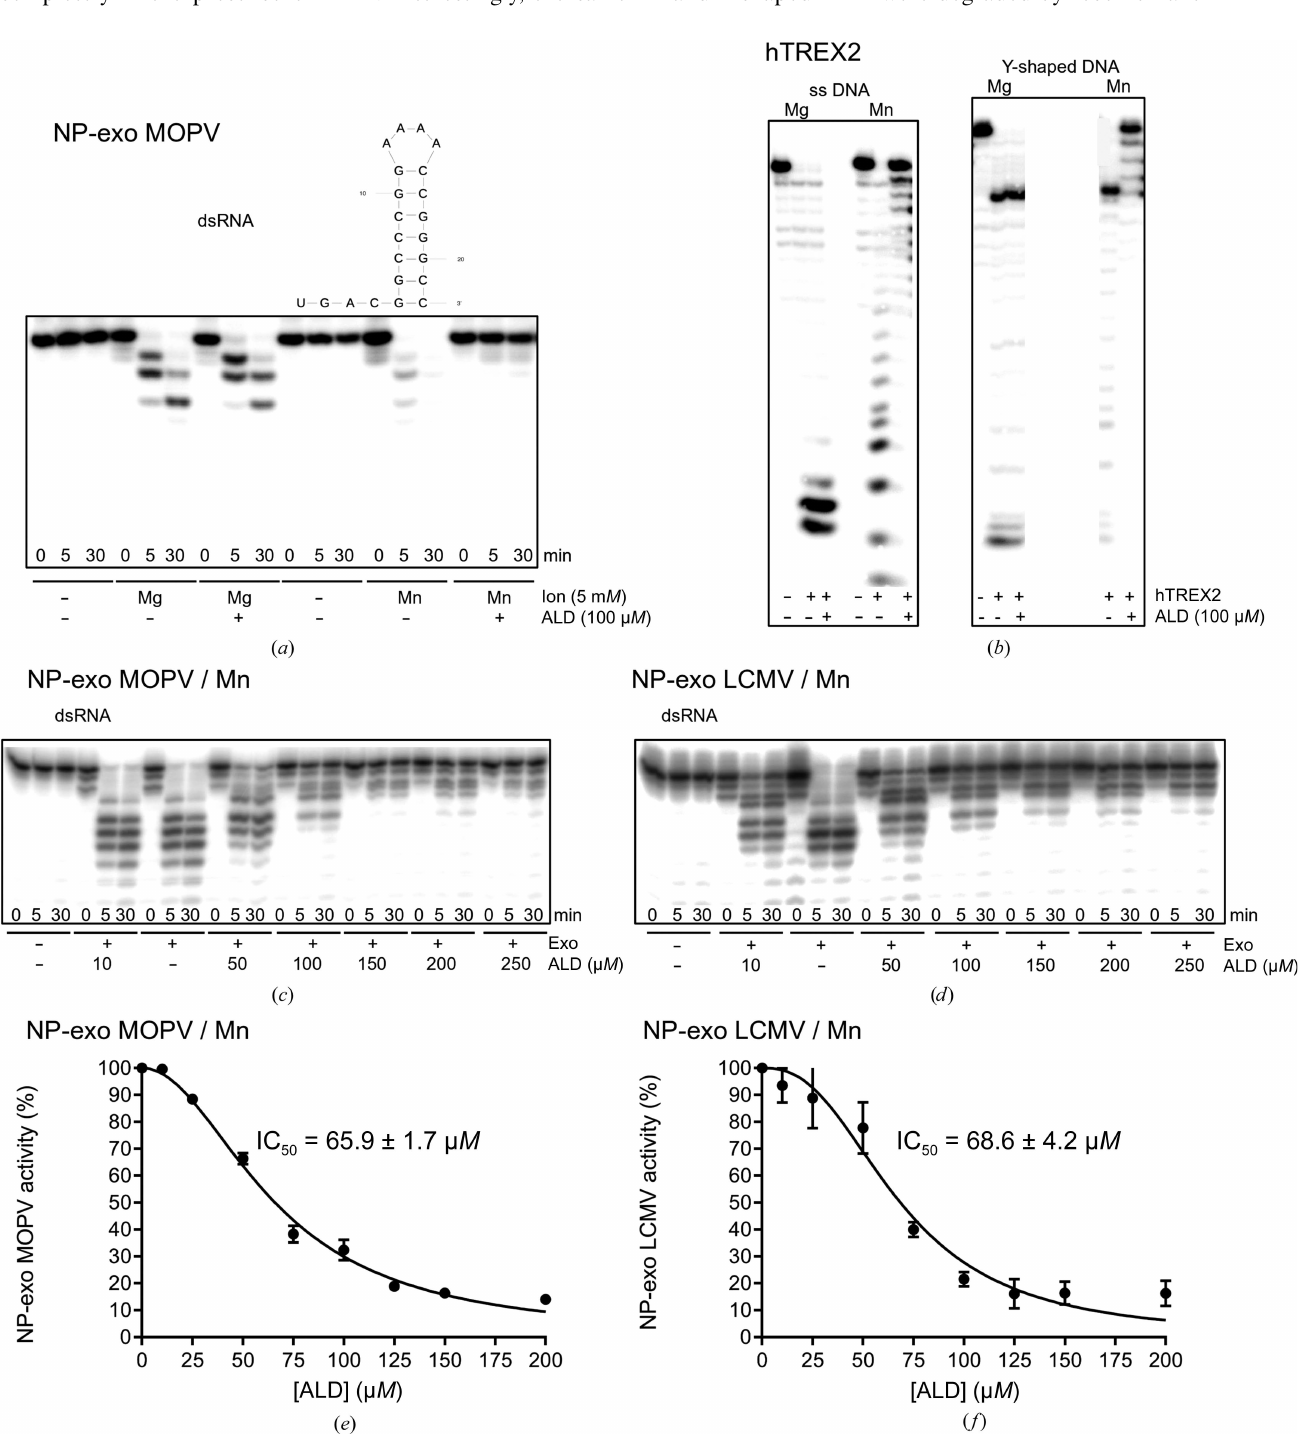
Figure 2 ALD inhibition of 3 0 –5 0 exonuclease activity. ( a ) MOPV NP-exo was incubated with HP4 dsRNA in the absence or presence of the catalytic ions Mg 2+ or Mn 2+ and a fixed concentration of ALD (100 m M ). Reaction samples were taken after time intervals of 0, 5 and 30 min. The products were analyzed on urea–PAGE and visualized by autoradiography. ( b ) Inhibition of hTREX2 activity in the presence of 100 m M ALD. Left, inhibition of hTREX2 activity on single-stranded DNA (ssDNA); right, inhibition of hTREX2 activity using Y-shaped DNAwith four-nucleotide 3 0 - and 5 0 -overhangs. ( c ) and ( d ) show representative gels showing the effect of ALD on the exonuclease activity of MOPV NP-exo and LCMV NP-exo, respectively. ( e ) and ( f ) are dose– response curves, from which IC 50 values were calculated. For IC 50 determination, the percentage of activity was measured by quantifying the total product formed after 5 min. IC 50 values were then determined by fitting the dose–response curves. Reactions were performed in